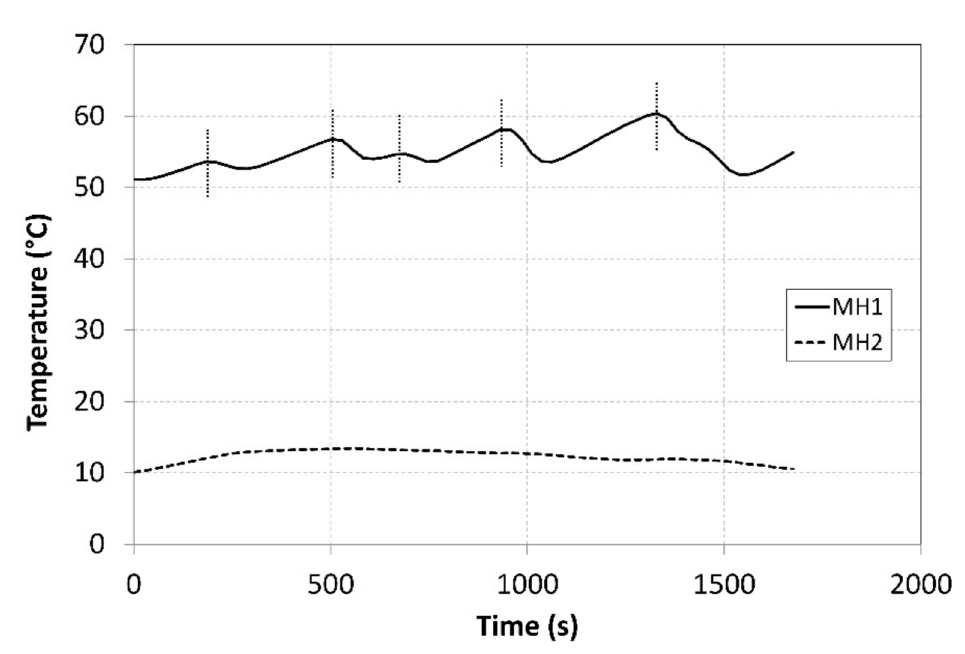
Figure 8. Curves of the temperatures in the tanks during